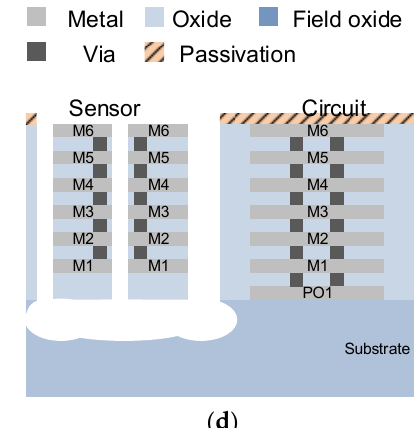
Figure 1. The proposed accelerometer: ( a ) The top view of the proposed accelerometer; ( b ) mechanical model of the structure; ( c ) circuit model of the structure; and ( d ) the side view of the structure.